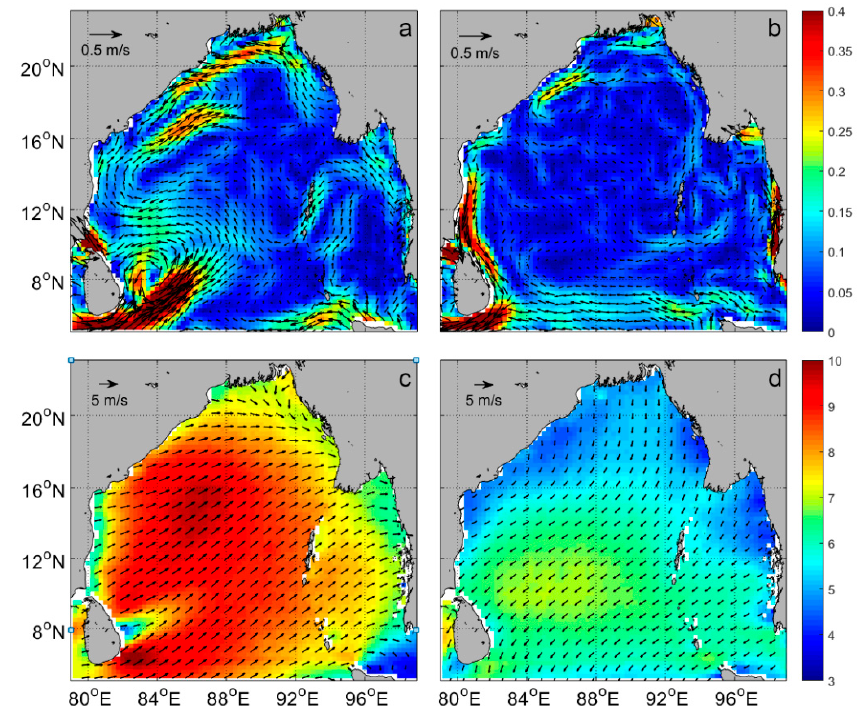
Figure 2. Upper panels: average surface currents in summer (June, July and August) ( a ) and winter (December, January and February) ( b ) over the 1993–2018, 26-year period (unit: m / s). Lower panels: average surface wind speed in summer ( c ) and winter ( d ) over the 2007–2018 period (unit: m / s). The vectors correspond to surface wind speed and direction.